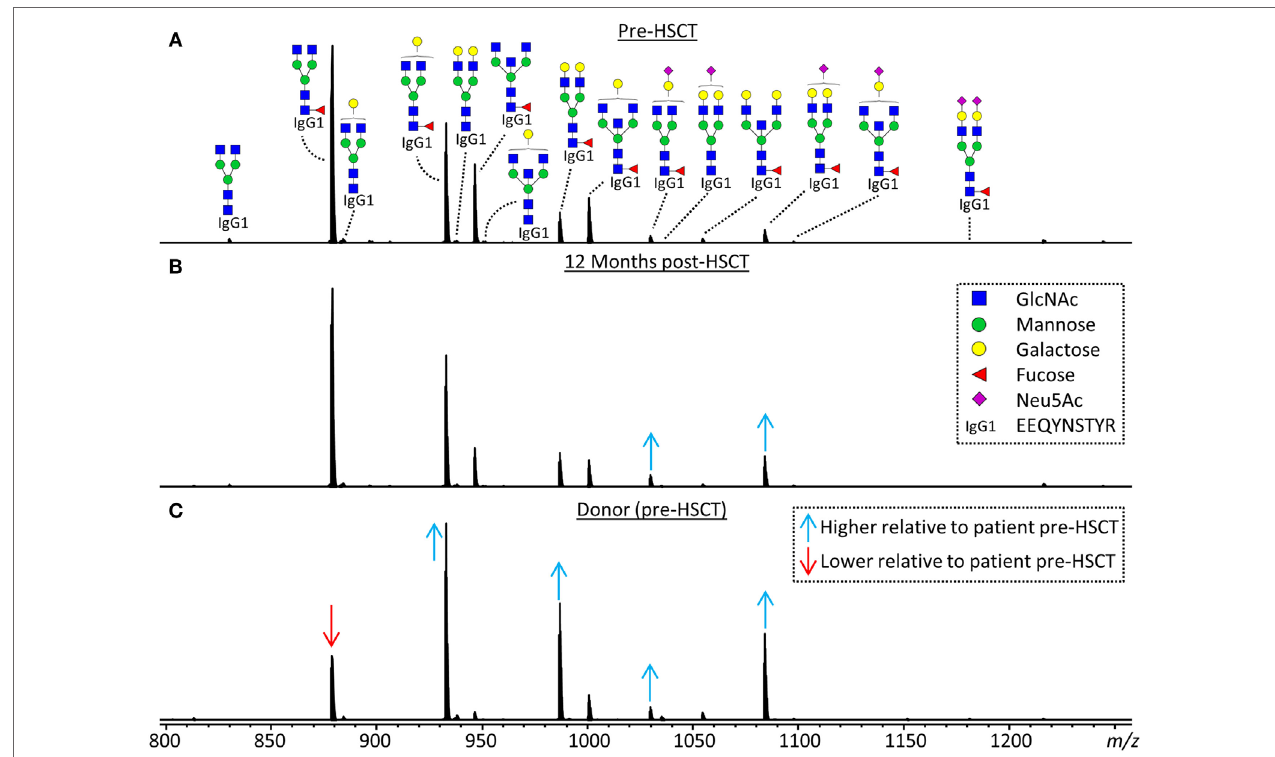
FigUre 2 | Representative mass spectra of IgG1 glycopeptides. Annotated are the 15 most abundant IgG1 glycoforms detected for a 7.5 years old, male, acute myeloid leukemia patient (a) before hematopoietic stem cell transplantation (HSCT), (b) 12 months after HSCT and (c) his 24 years old, healthy, male donor. Triply charged glycopeptides are shown, the proposed glycan structures are based on literature (6, 13, 20, 21). Green circle: mannose, yellow circle: galactose, blue square: N -acetylglucosamine (GlcNAc), red triangle: fucose, pink diamond: N -acetylneuraminic acid (Neu5Ac). Differences in relative abundances of glycoforms as compared to the patient pre-HSCT are indicated by red (lower than in pre-HSCT patient) and blue (higher than in pre-HSCT patient)